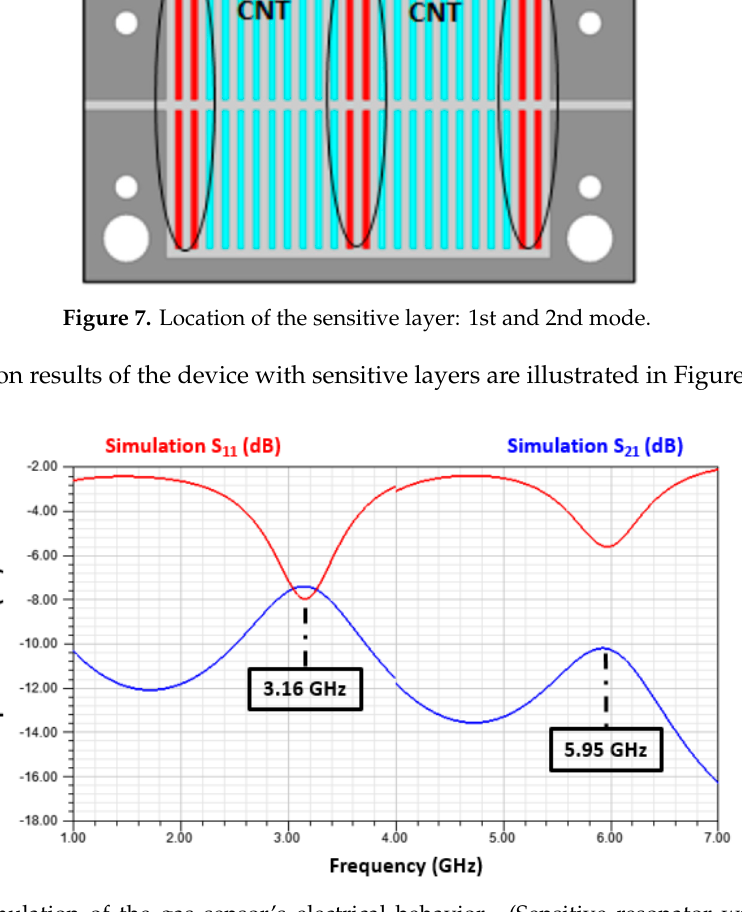
Figure 8. Simulation of the gas sensor’s electrical behavior. (Sensitive resonator with PEDOT: PSS- MWCNTs).